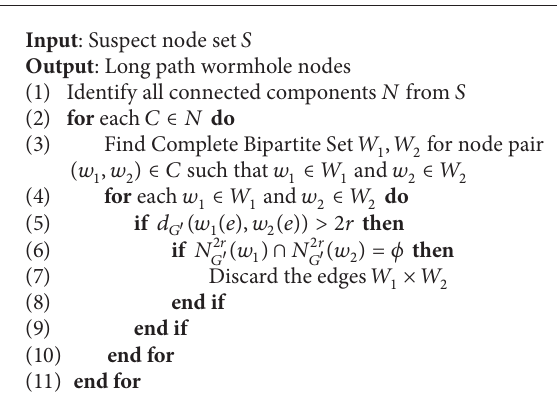
Algorithm 3: Long path wormhole detection